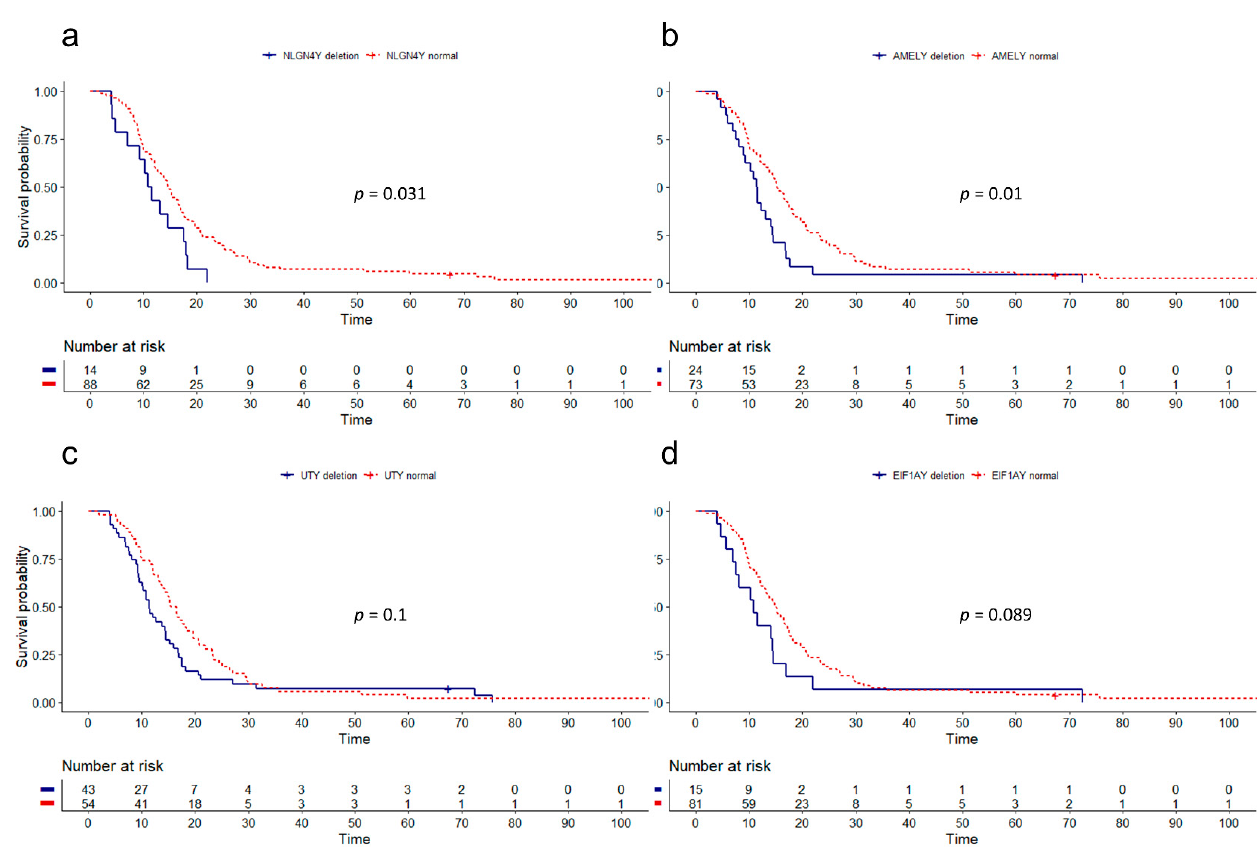
Figure 2. The log-rank Kaplan–Meier survival curves for genes ( a ) NLGN4Y (10.8 vs. 14.5 months, p = 0.031), ( b ) AMELY (11.5 vs. 15.2 months, p = 0.01), ( c ) UTY (11.5 vs. 15.3 months, p = 0.1), and ( d ) EIF1AY (10.8 vs. 15.1 months, p = 0.089) after re-analysis with the ddPCR CN cut-off value of 0.8.